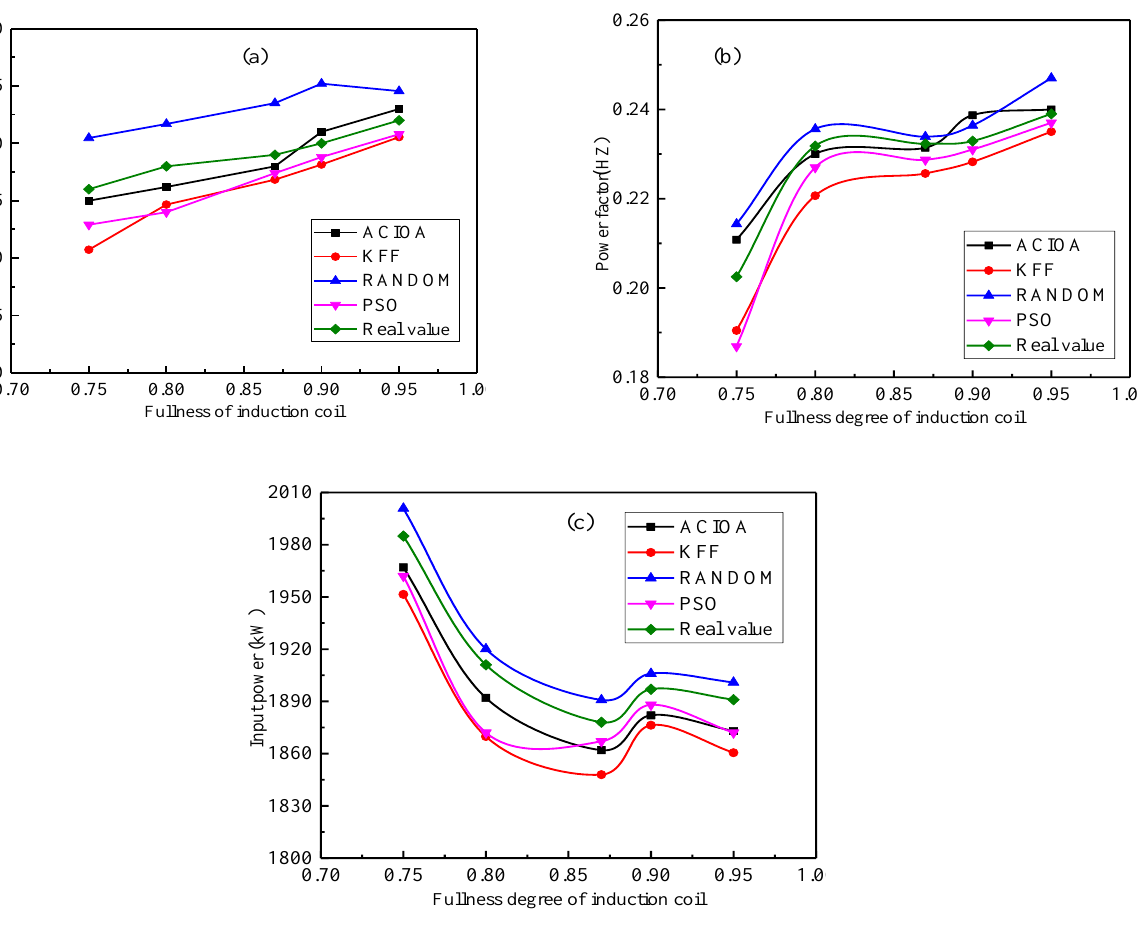
Figure 7. Effect of fullness of induction coil on circuit performance parameters. ( a ) thermal efficiency; ( b ) power factor; ( c ) input power.